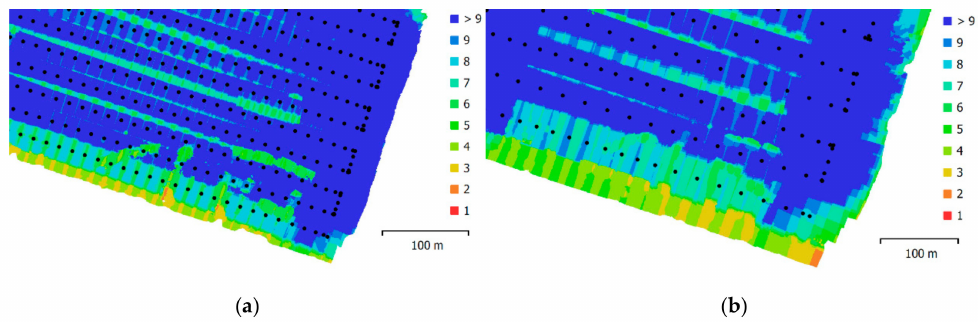
Figure 10. Camera location and image overlap for the Mavic Pro at ( a ) 55 m and ( b )